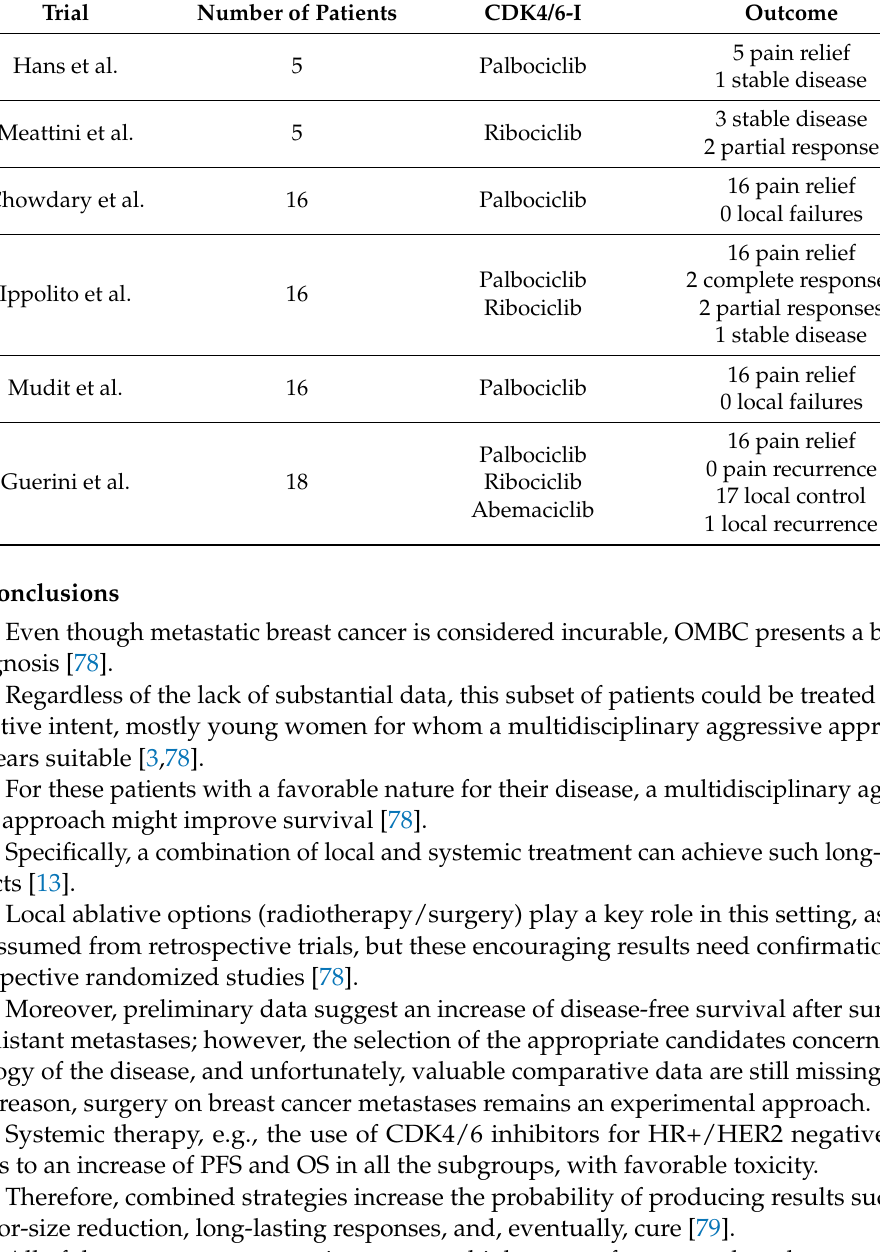
Table 2. Trials that evaluate the efficacy of concomitant RT and CDK4/6-i in MBC. Trial Number of Patients